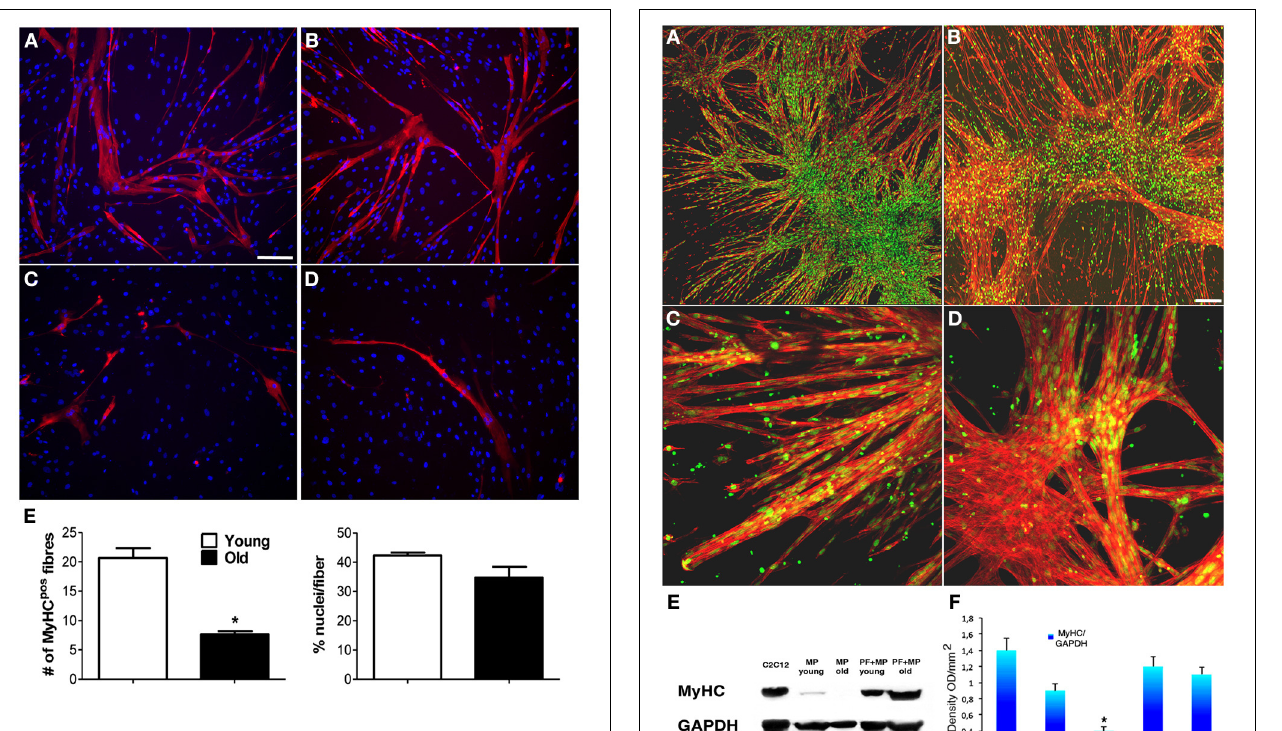
FIGURE 3 | Myogenic capability of MP in vitro . Myogenic ability was assessed for muscle-derived pericytes (MP). (A–D) Immunofluorescence staining with anti-myosin heavy chain (MyHC) antibody. Representative images showing MyHC-positive (pos) myotubes (red) formed from young (A,B) and old (C,D) MP, demonstrating that age affects MP muscle differentiation capacity. Nuclei were counterstained with 4,6-diamidino-2-phenylindole (DAPI). (E) Average data extracted from (A–D) immunolabeling. The number of positive fibers was quantified with respect to the total number of nuclei. The efficiency of cell fusion into syncytial myofibers was measured as percentage of nuclei per fiber. The analysis was done on five pictures from three donor/group. Values are expressed as mean ± s.e.m. ∗ p < 0 . 05 vs. young MP. Scale bar: (A–D) 50 μ m.